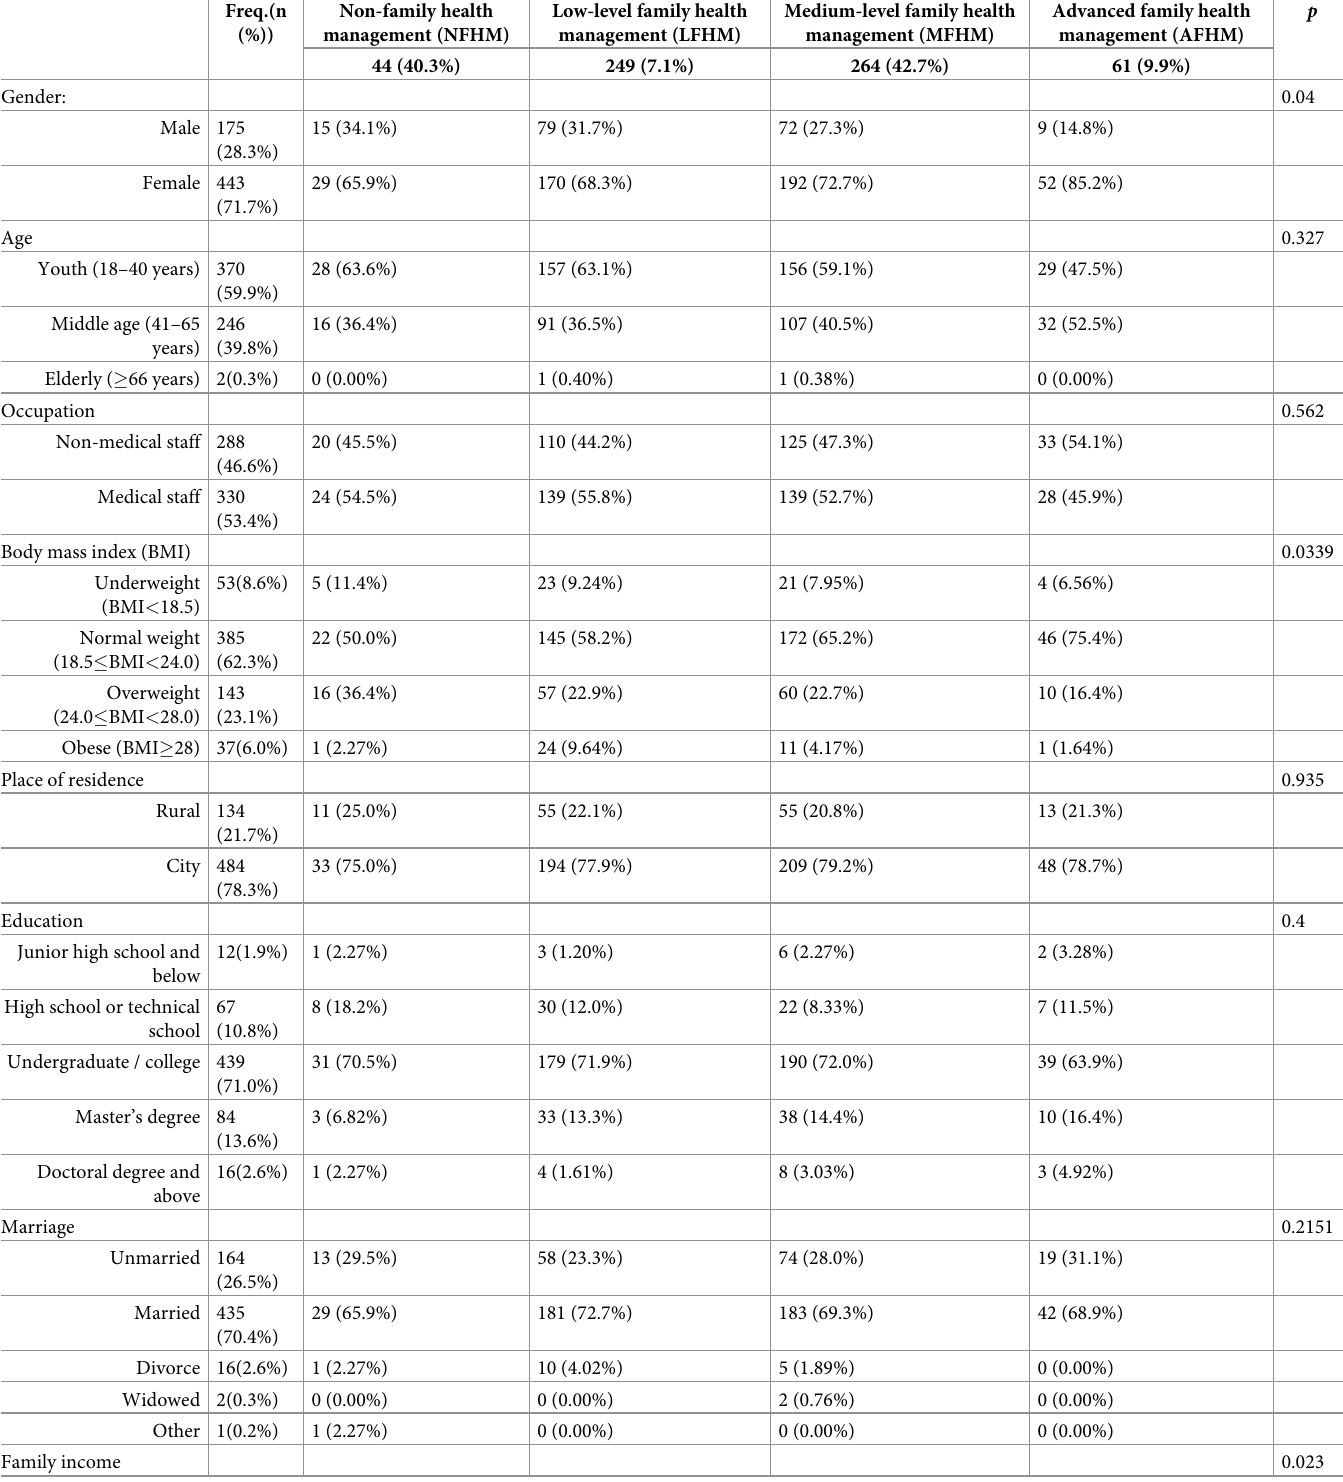
Table 3. Influential factors for latent family health management